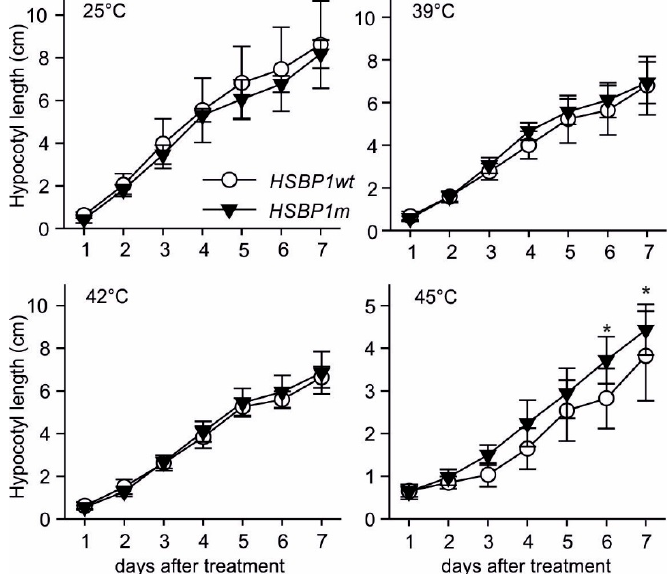
Figure 4. Effect of heat stress on hypocotyl elongation of SlHSBP1wt and SlHSBP1m seedlings. Four-day-old seedlings were exposed to the indicated temperatures for one hour, and then allowed to grow for 7 days at 25 °C in the dark. Thermotolerance is estimated by the ability of seedlings to recover from stress based on their hypocotyl growth. Values are an average of 10 seedlings ±SD. Asterisks indicate significant difference ( p < 0.05) between the two genotypes for the indicated day based on Student’s t -test.